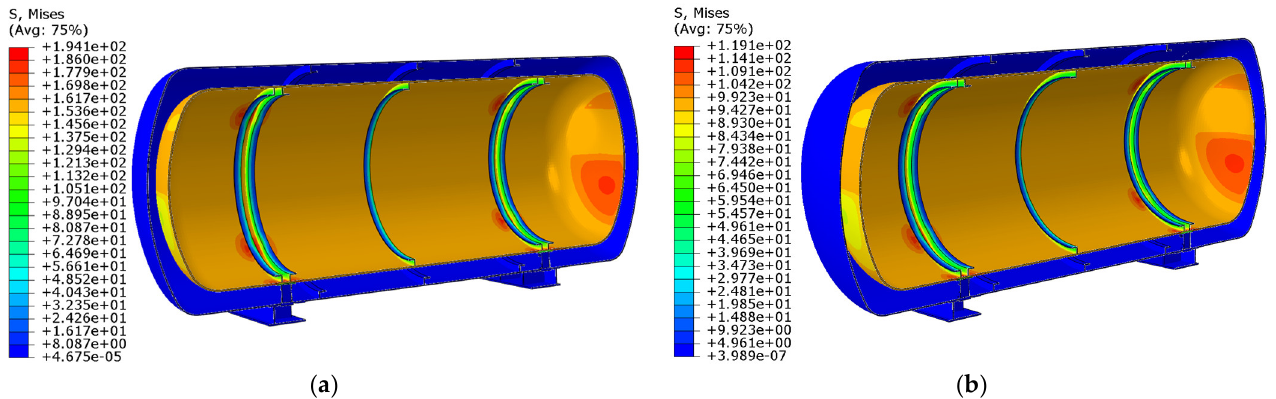
Figure 10. Thermal stress distribution of LNG fuel tank: ( a ) SUS304; ( b ) AL-5083-O.